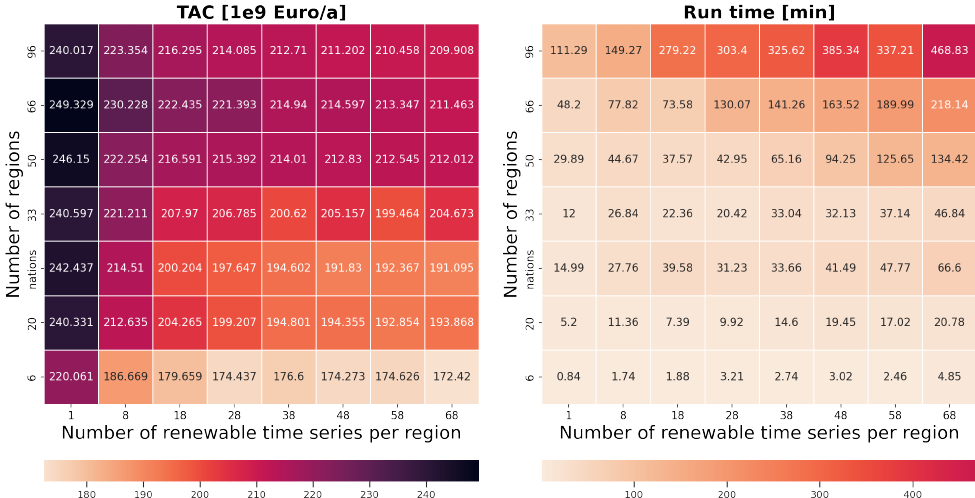
Figure 9. TAC obtained and the associated run time for each combination of parameters considered in this study.